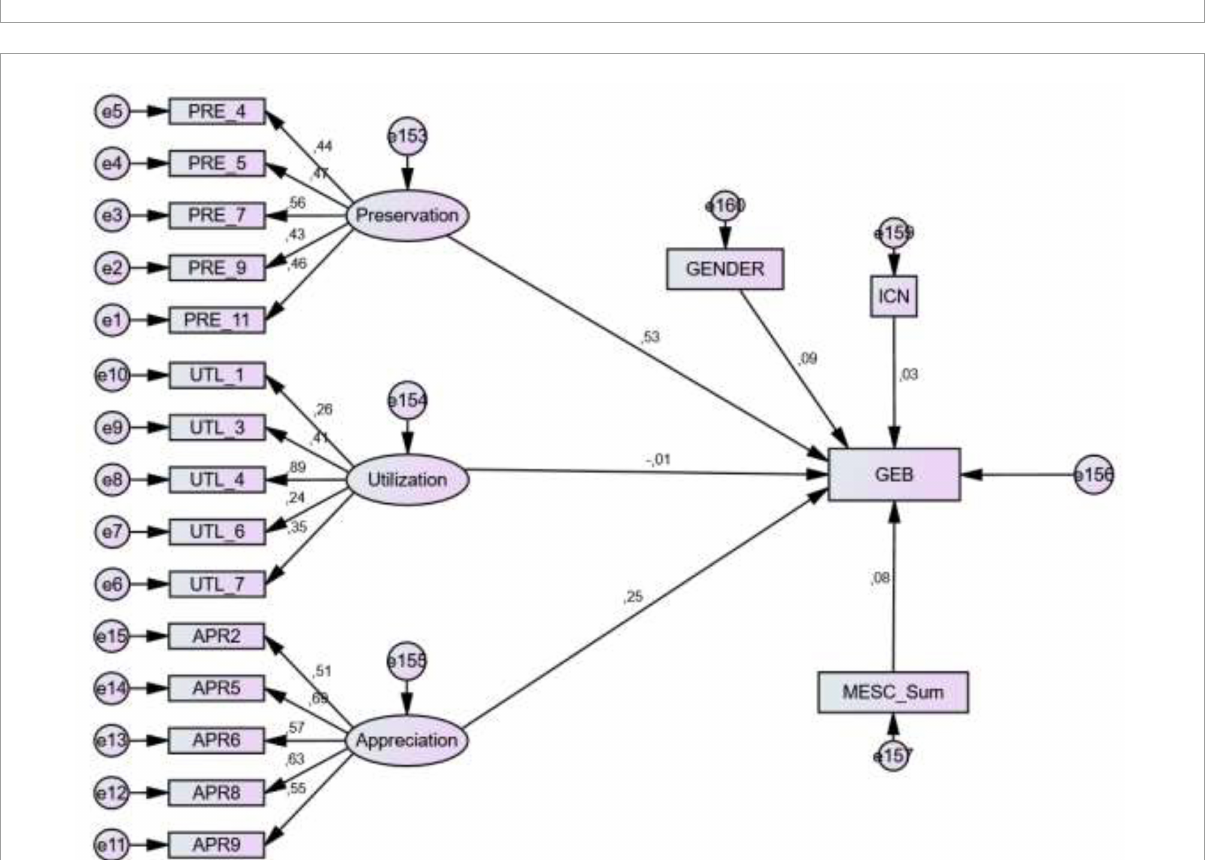
FIGURE3 A path analysis of variables involved in the reported behavior General Ecological Behavior